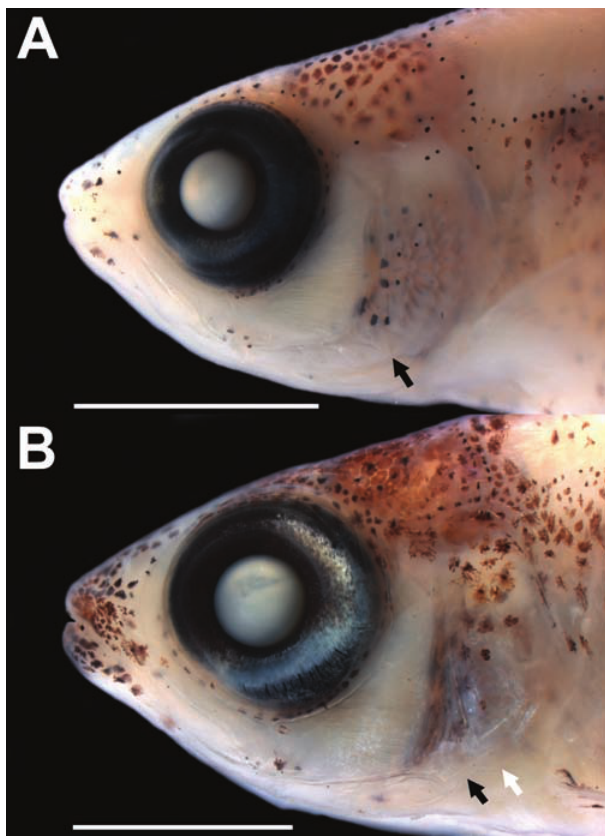
Fig. 6. Larvae of Heterocharax macrolepis , lateral view of head. A: 13.6 mm SL; B: 16.2 mm SL. Black arrows indicate posteroventral border of preopercle and white arrow indicates tip of preopercle spine in (B). Scale bar: 2